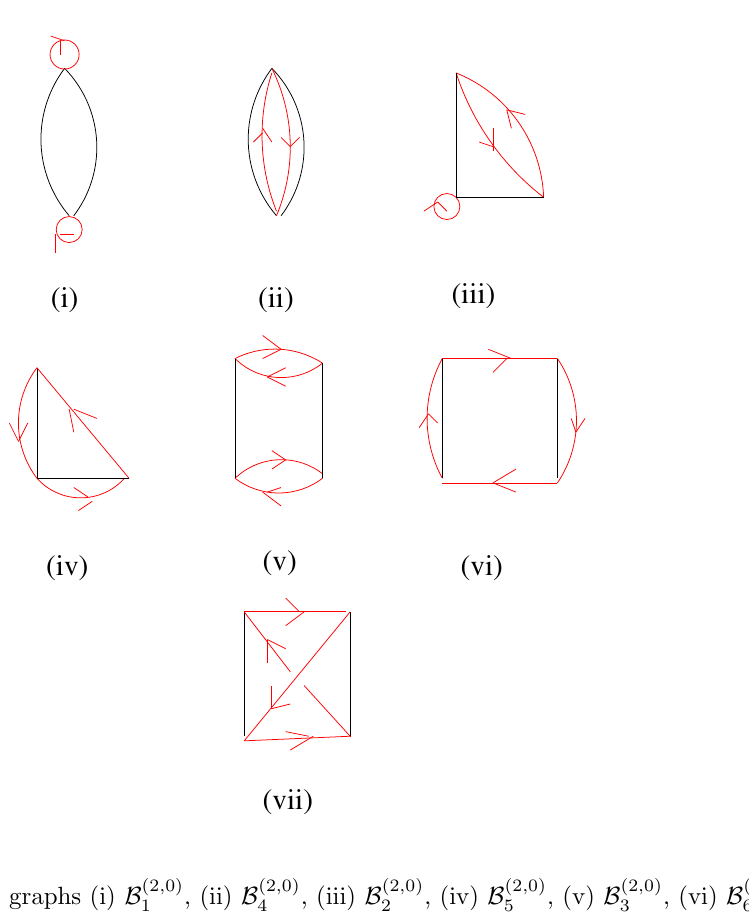
Figure 26 . The modular graphs (i) B (2 ; 0)